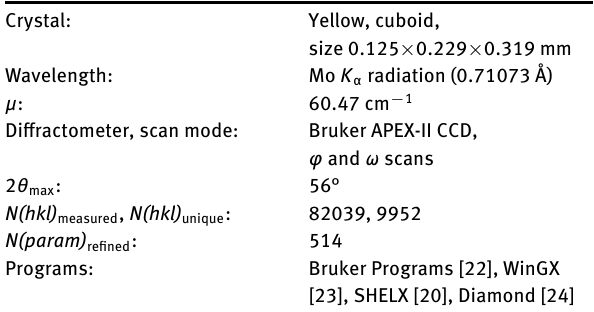
Table 1: Data collection and handling. Crystal: